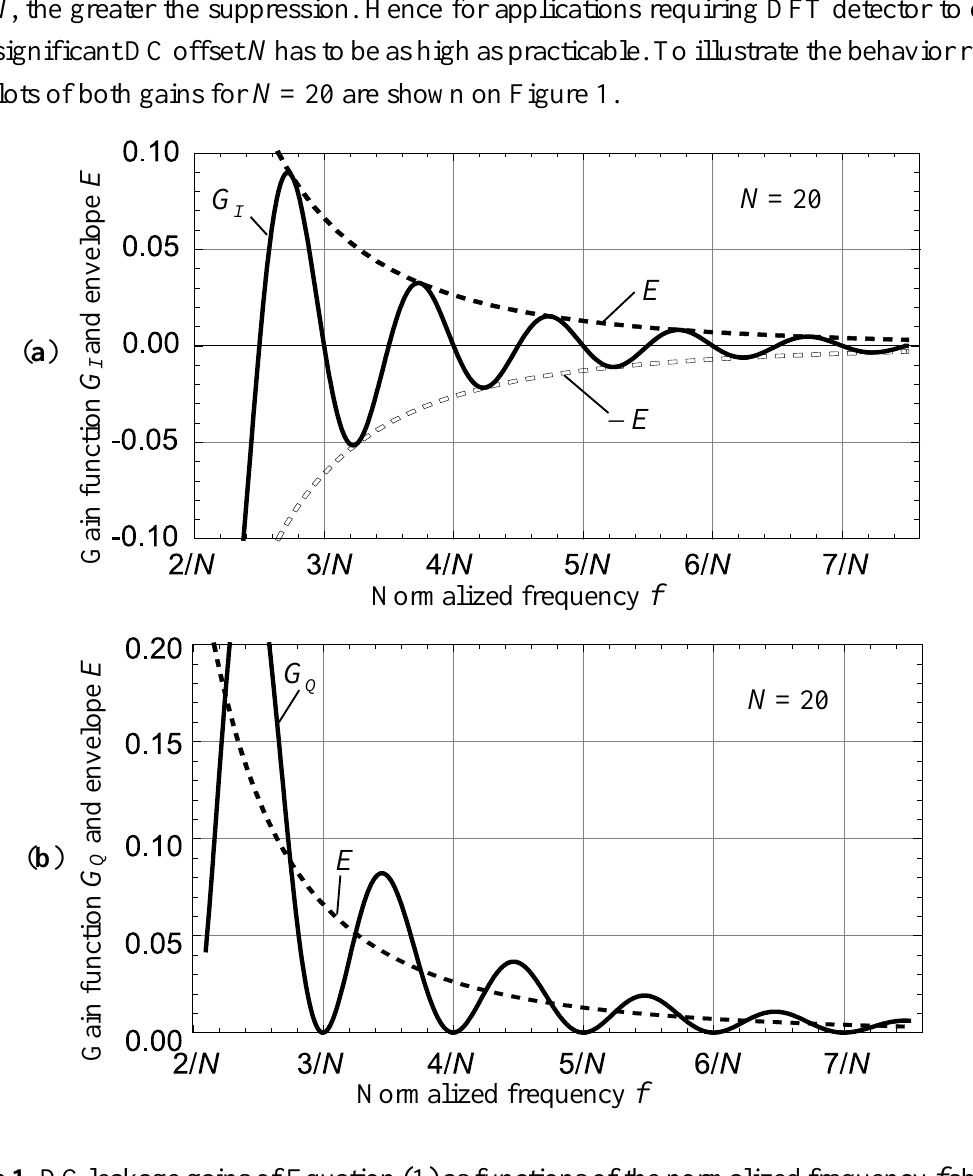
Figure 1. DC leakage gains of Equation (1) as functions of the normalized frequency f above f = 2/ N : ( a ) in-phase component G I ; and ( b ) quadrature component G Q